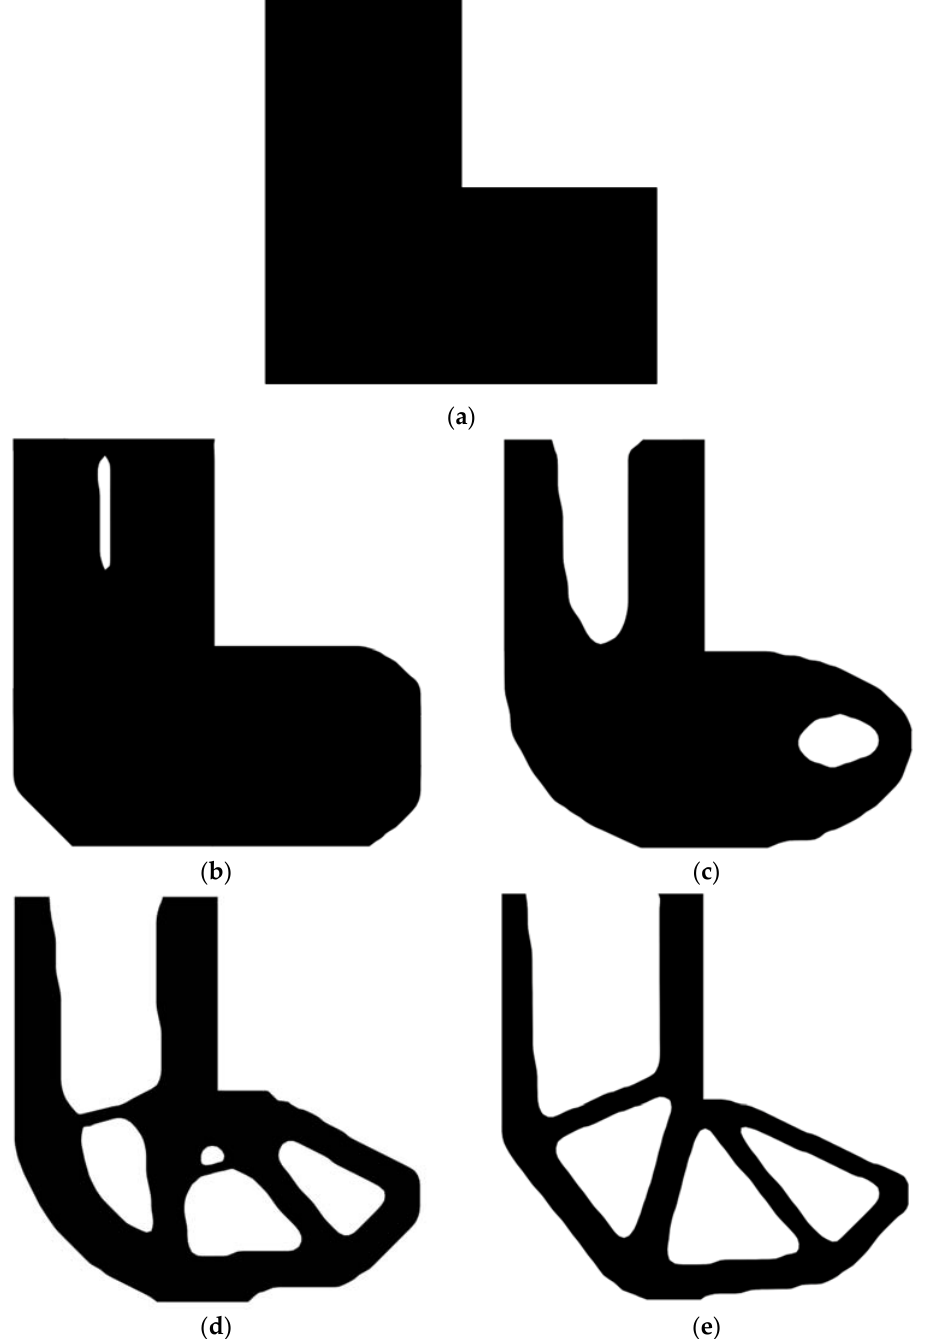
Figure 29. Optimal design problem of L-shaped beam by CBT level set topology